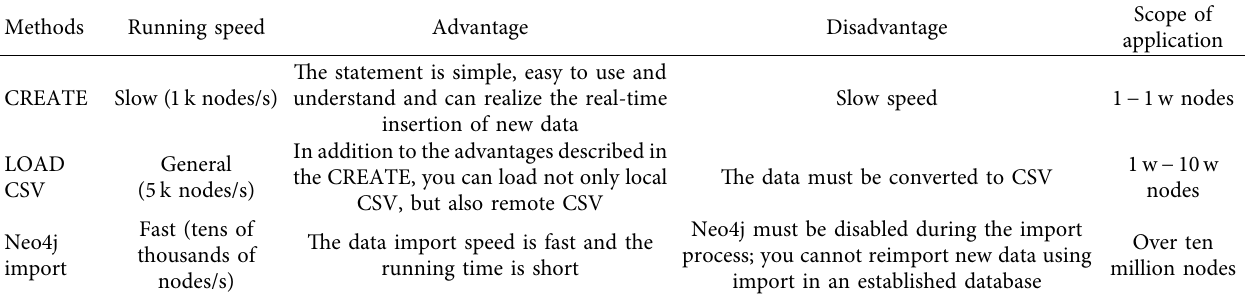
Table 4: Comparison of methods for importing data in batches into